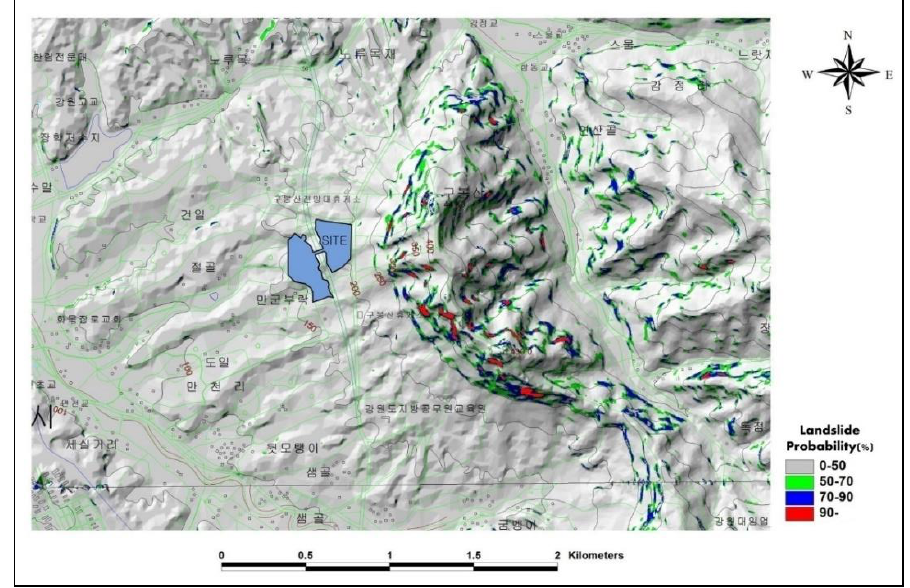
Figure 6. Landslide probability map of Mt Goobong (after [11]).